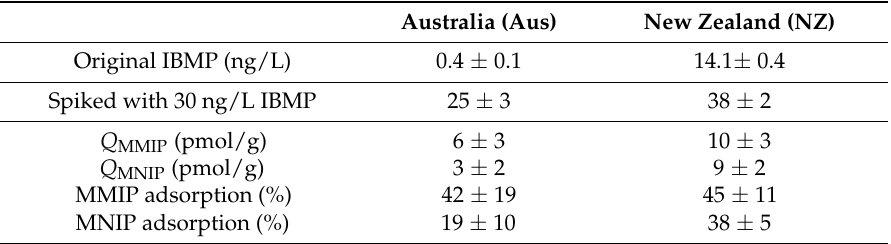
Figure 7. Magnetic separation of putative MMIP in white wine samples. Table 3. Adsorption of IBMP (mean ± SD, n = 3) by thermally synthesised MMIP and MNIP in commercial Sauvignon Blanc wines spiked with IBMP.